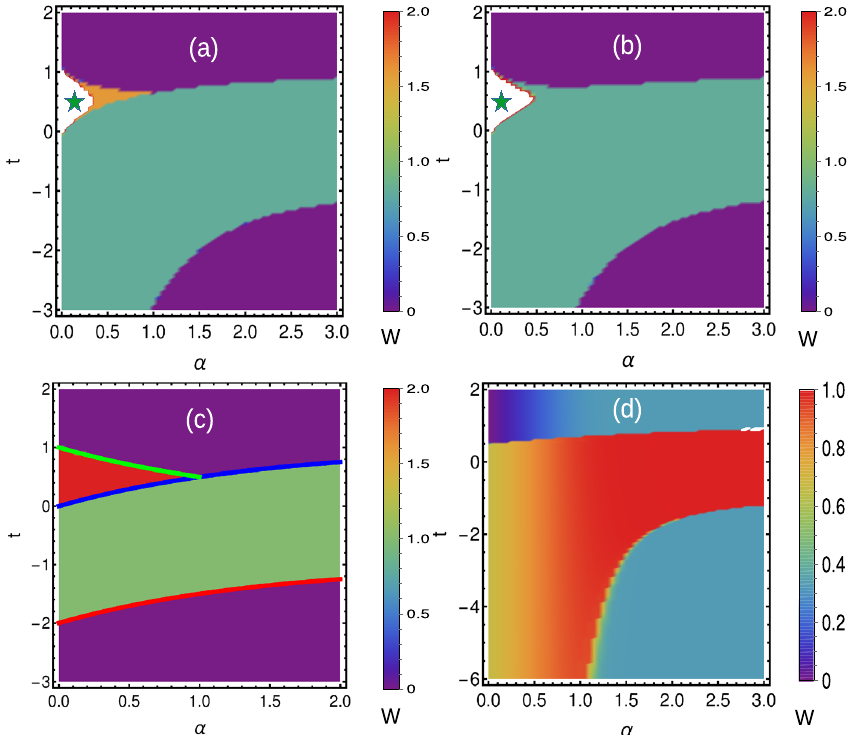
Figure 4. (Color online) Phase diagrams of Hermitian SSH chain with periodic boundary conditions. ( a ) Extended-range model with even number of neighbors. ( b ) Extended-range model with odd number of neighbors. ( c ) Simple extended-range model with two neighbors ( d ) Long-range model with infinite neighbors. Here the star symbol represents the region of higher WNs, which are less stable compared to their lower WNs.